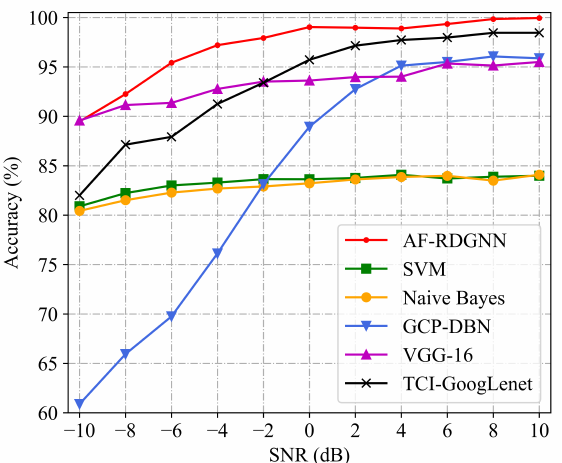
Figure 5. Comparison of recognition accuracy of different methods when the maximum frequency offset is 50